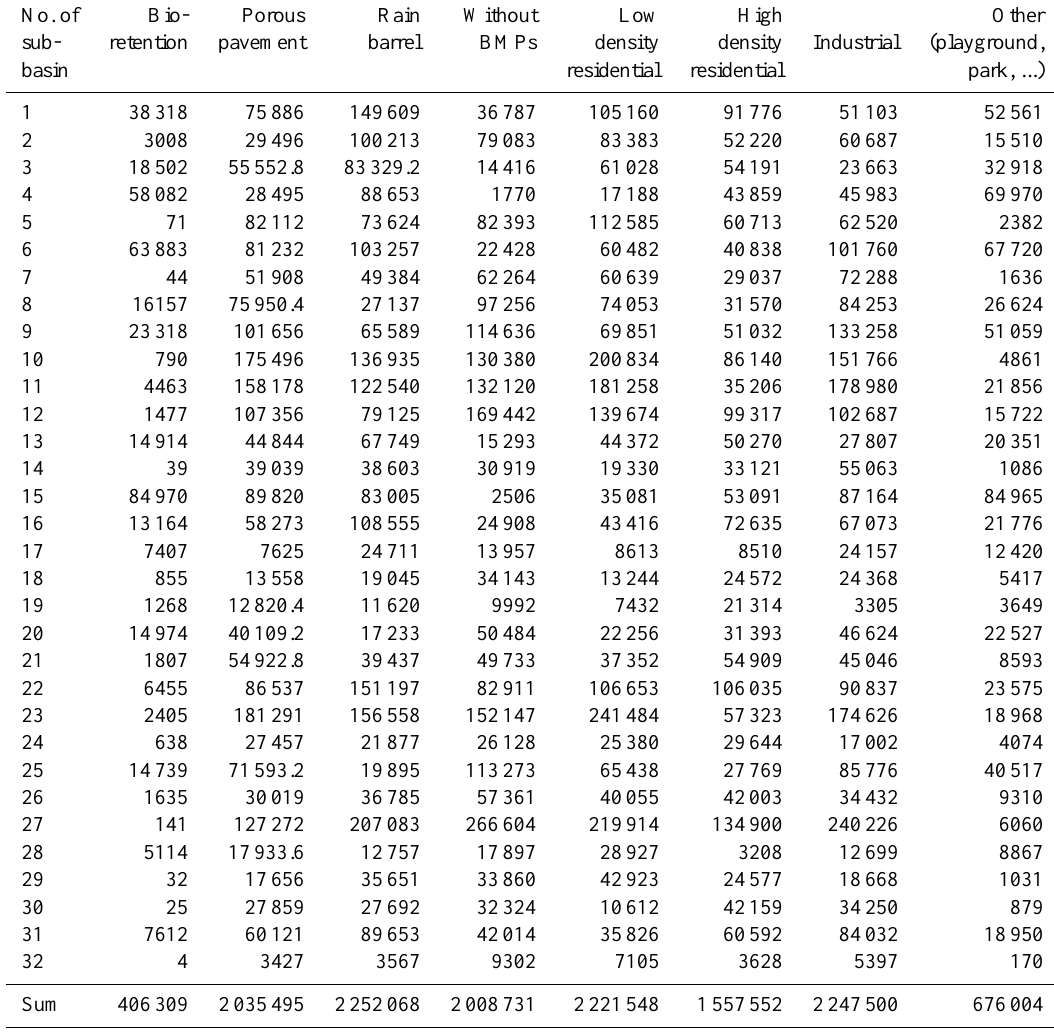
Table 9. Optimal level of coverage (km 2 ) associated with class